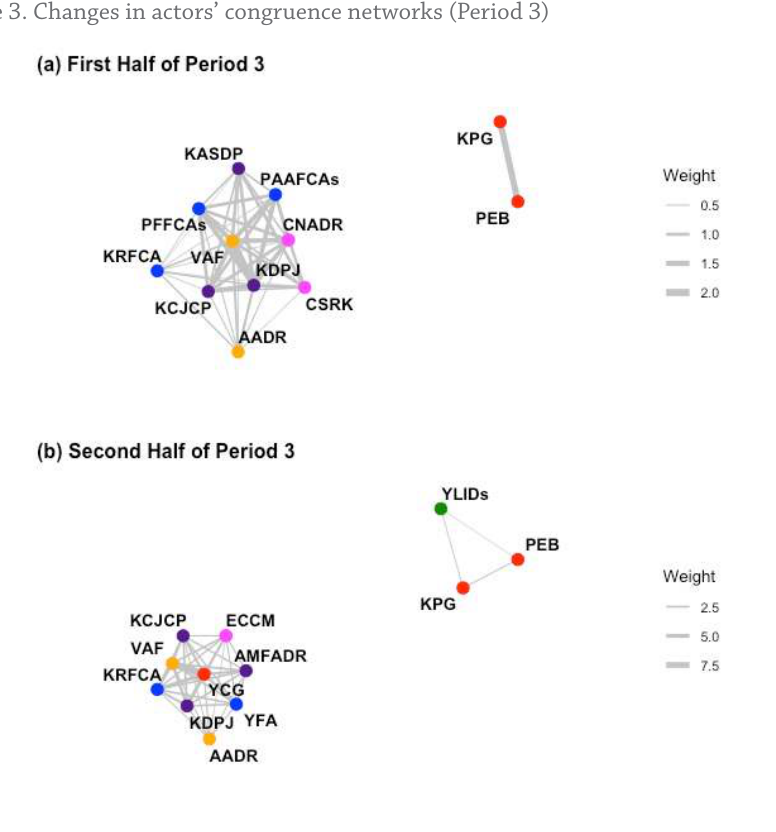
Figure 3. Changes in actors’ congruence networks (Period